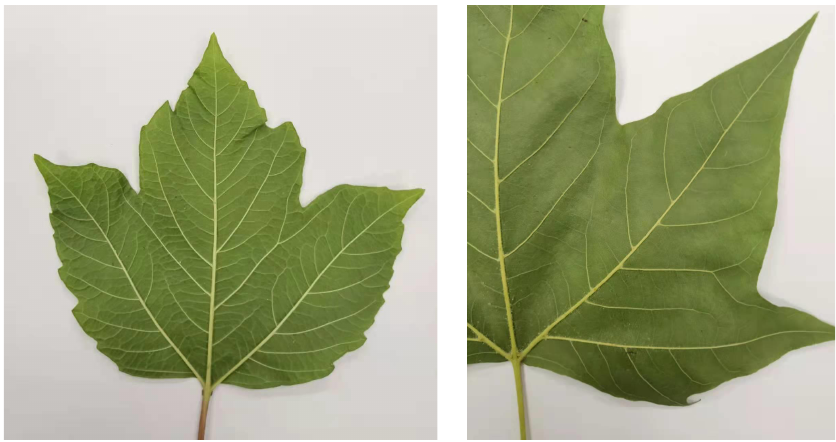
Figure 1. Leaf veins in nature, photos are taken by the first author.